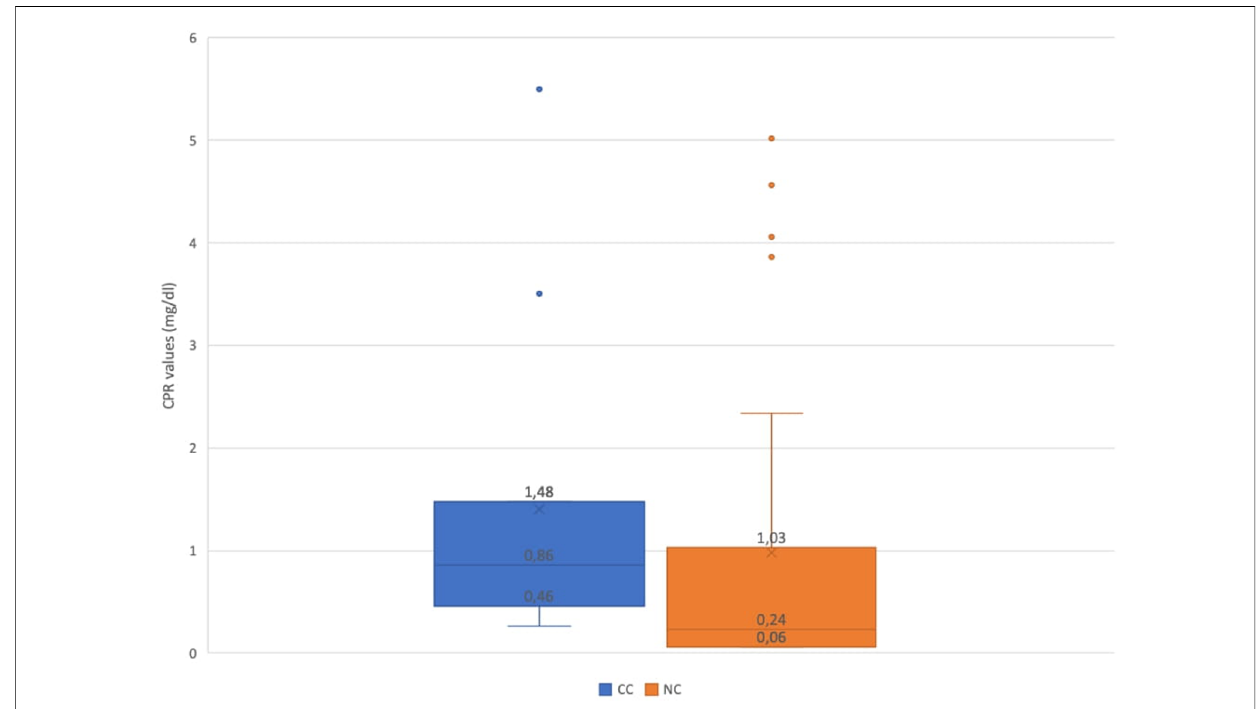
FIGURE 2 Comparison of C-reactive protein values of children with NC and CC. NC, noncomplicated COVID-19; CC, complicated